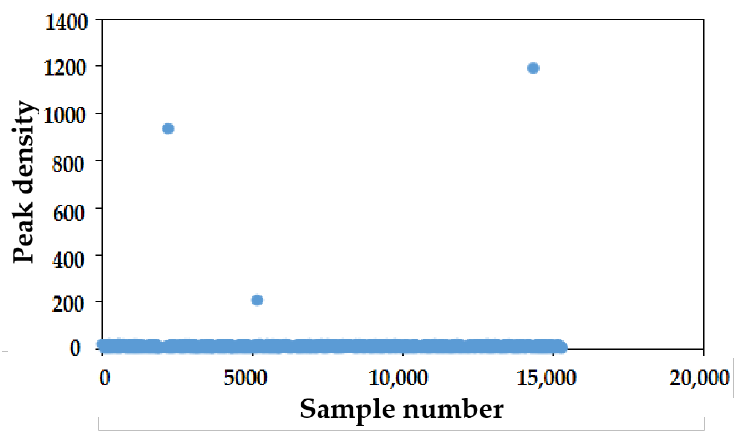
Figure 7. Peak density of sample points.